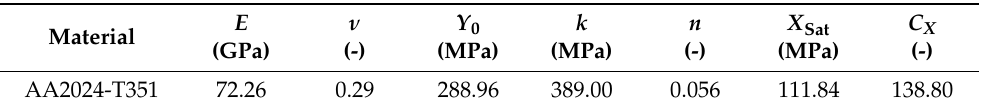
Table 1. Elastic properties and Swift and Armstrong–Frederick laws’ parameters obtained for the 2024-T351 aluminium alloy.